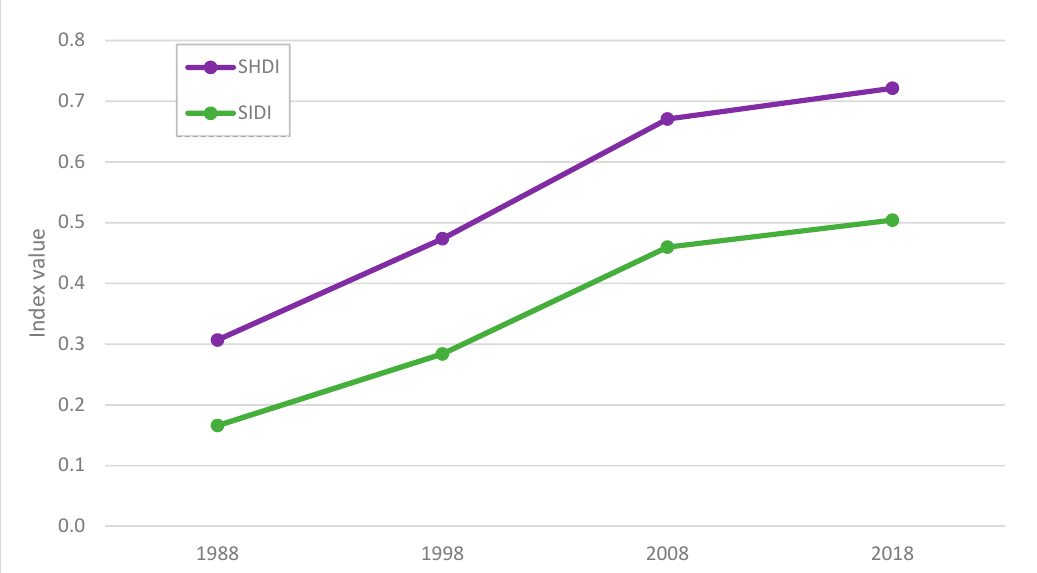
Figure 9. Evolution of the diversity indices, Shannon’s Diversity Index (SHDI) and Simpson’s Diversity Index (SIDI), from 1988 to 2018.